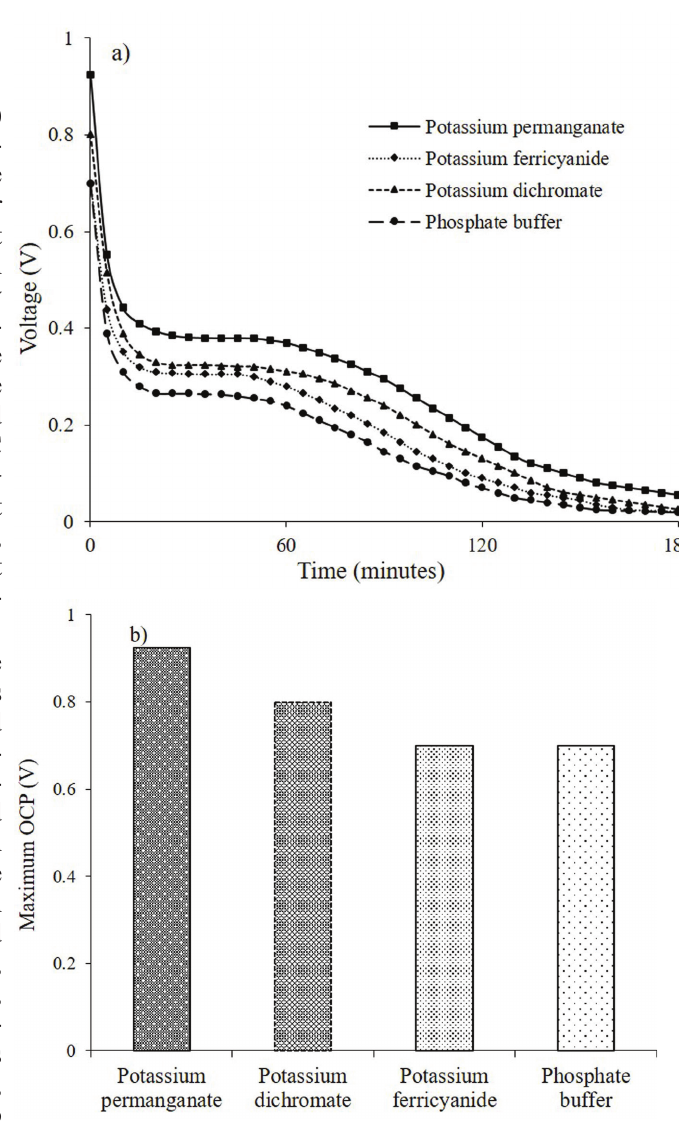
Fig. 3 – Voltage outputs (a), and open-circuit potentials (b) of the CW-MFCs with different oxidants as